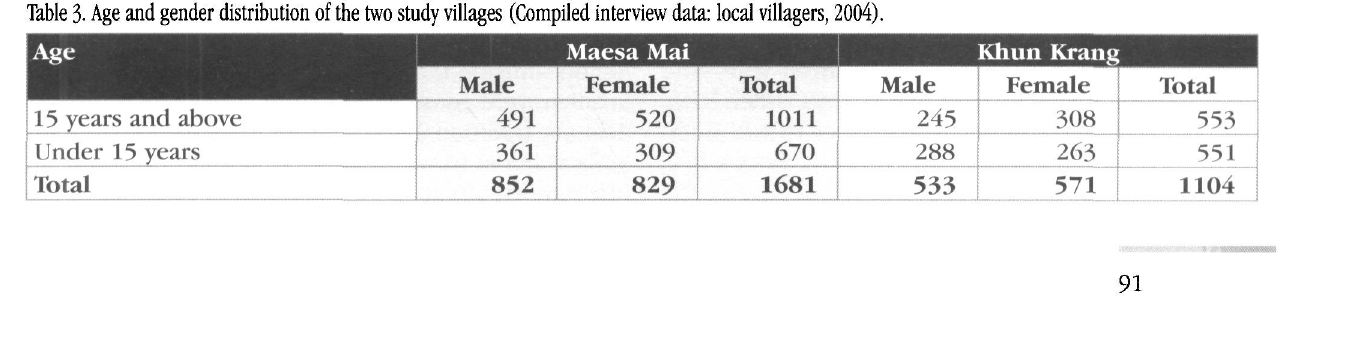
Table 3- Age and gender distribution of the two study villages (Compiled interview data: local villagers,